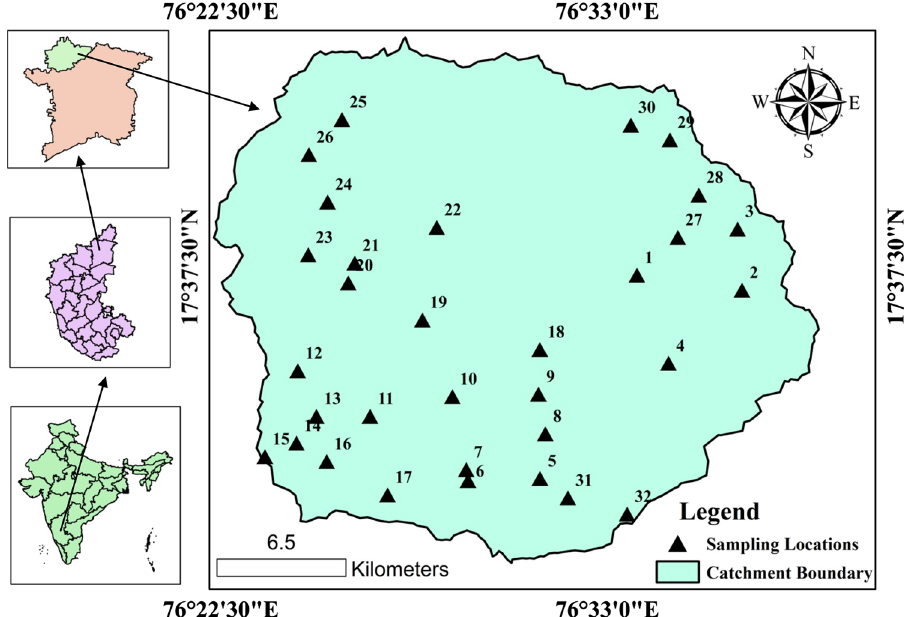
Fig. 1 Sampling location map of the study